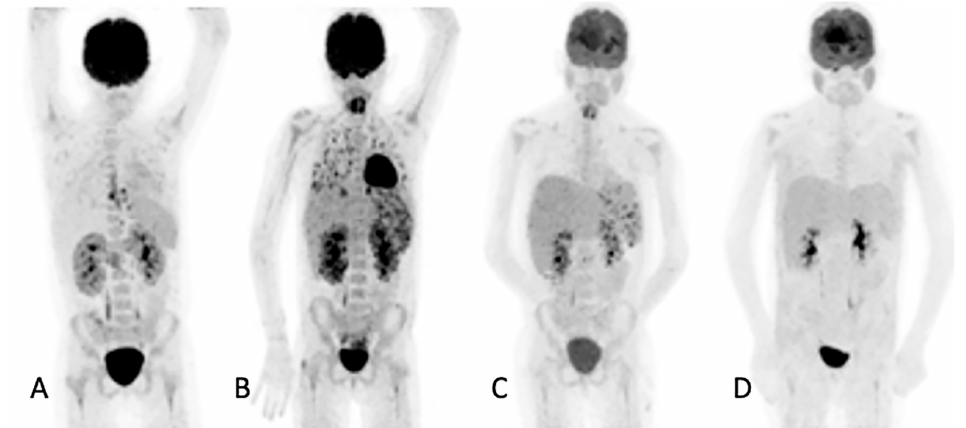
Figure 3. Ten-year-old female with acute myeloid lymphoma who developed a fever, on chemother- apy, with no response to antibiotics. An abdominal ultrasound demonstrated bilaterally enlarged kidneys. Initial [ 18 F]FDG PET/CT MIP image ( A ) showed focal metabolic uptake in kidneys, spleen and esophagus. She was started on antifungal treatment, but the fever persisted, and a repeat study ( B ) showed the worsening of renal splenic lesions with no pulmonary lesions. The antifungal treatment was changed; the fever subsided, and the serum infective markers decreased. A repeat [ 18 F]FDG PET/CT performed after 6 weeks ( C ) showed resolution of the pulmonary and most of the renal and splenic lesions. The treatment was continued for another month, and a follow-up [ 18 F]FDG PET/CT ( D ) showed a complete metabolic response that helped the clinician to end the antifungal treatment.